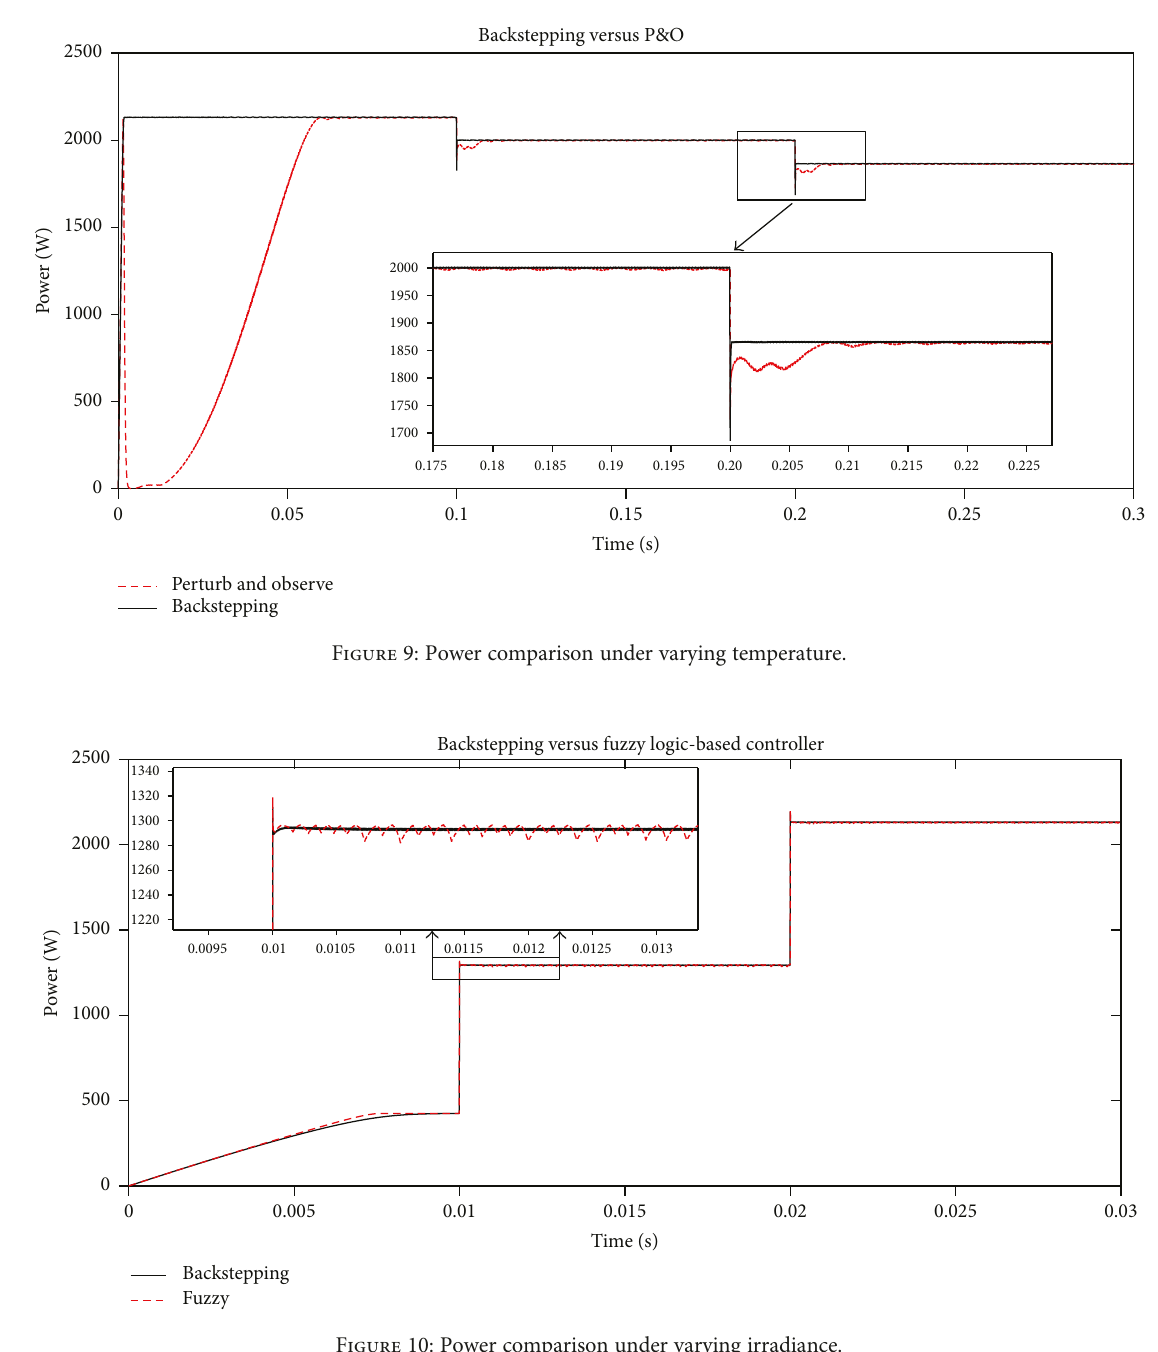
Figure 10: Power comparison under varying